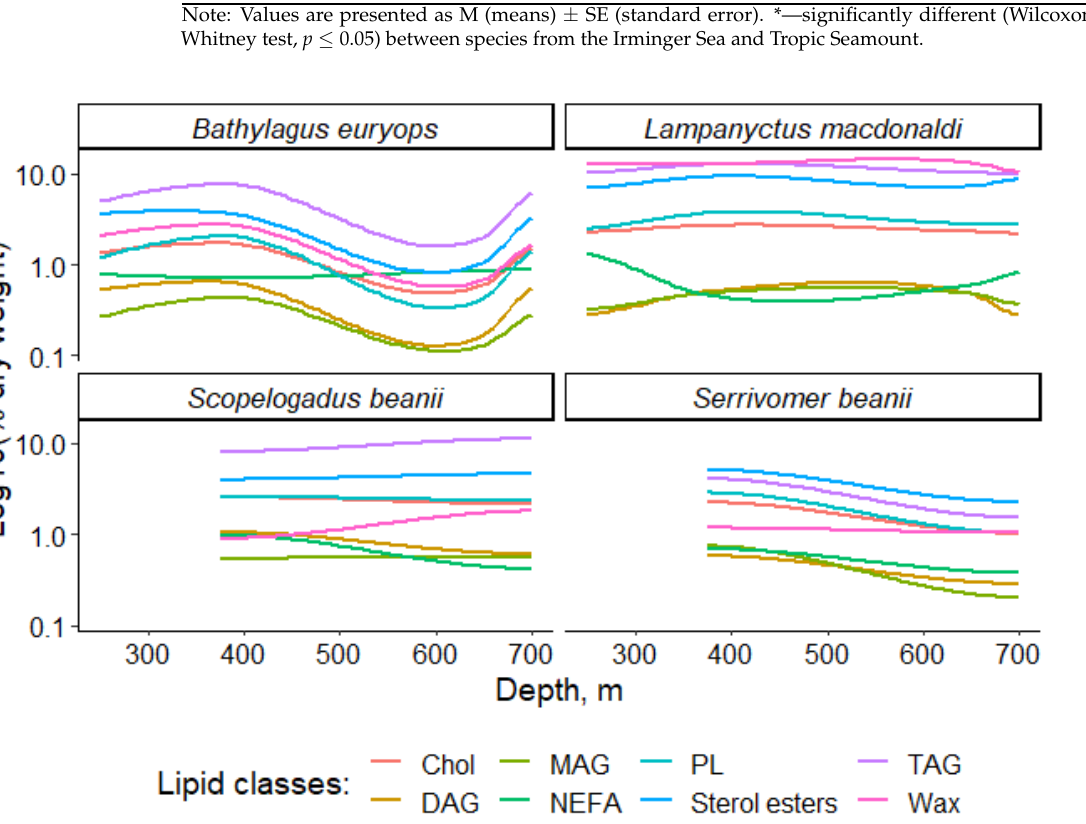
Figure 4. Patterns of change in individual lipid classes in muscles of mesopelagic fish species ( Bathylagus euryops , Lampanyctus macdonaldi , Scopelogadus beanii , Serrivomer beanii ) living at different depths in the Irminger Sea (North Atlantic). Note: abbreviations used as in Figure